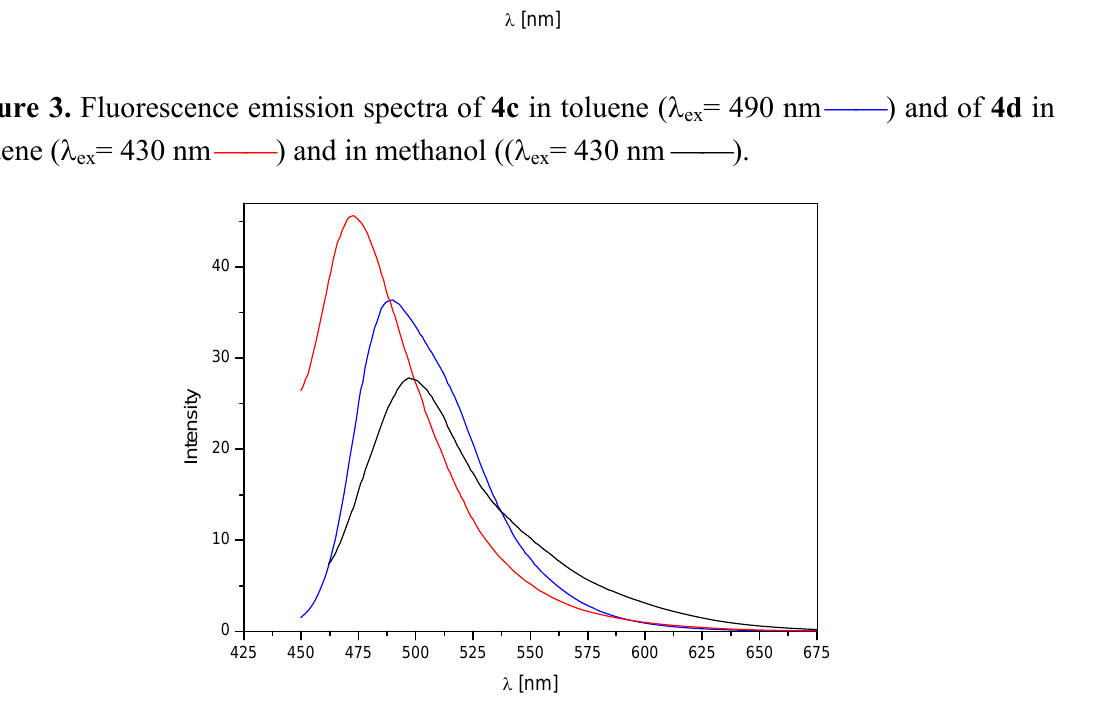
Figure 4. Bipolar structures. OR ' ON